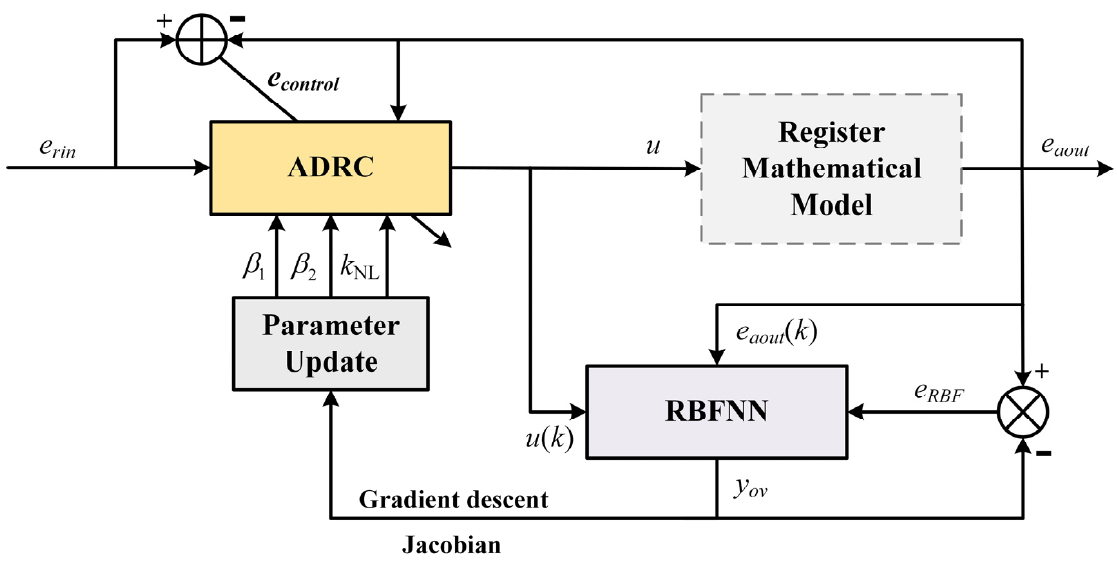
Figure 5. The structure of the parameters’ self-tuning controller.